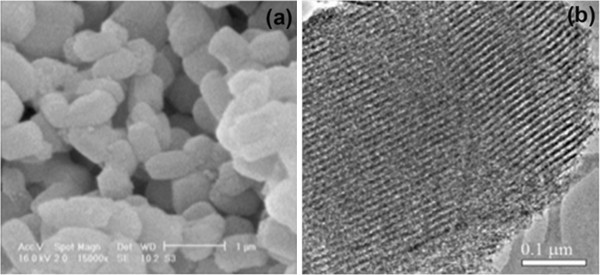
(a) SEM and (b) TEM images of SBA-Pr-SO3H.